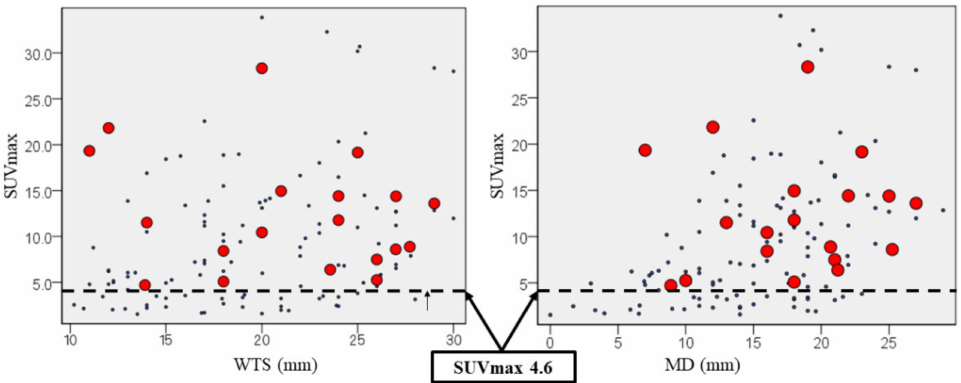
Figure 4. SUVmax ≥ 4.6 was useful to predict the recurrence regardless of HRCT parameters. Red spots revealed cancer recurrence. WTS; whole tumor size on lung window setting, and MD; diameter on mediastinal window